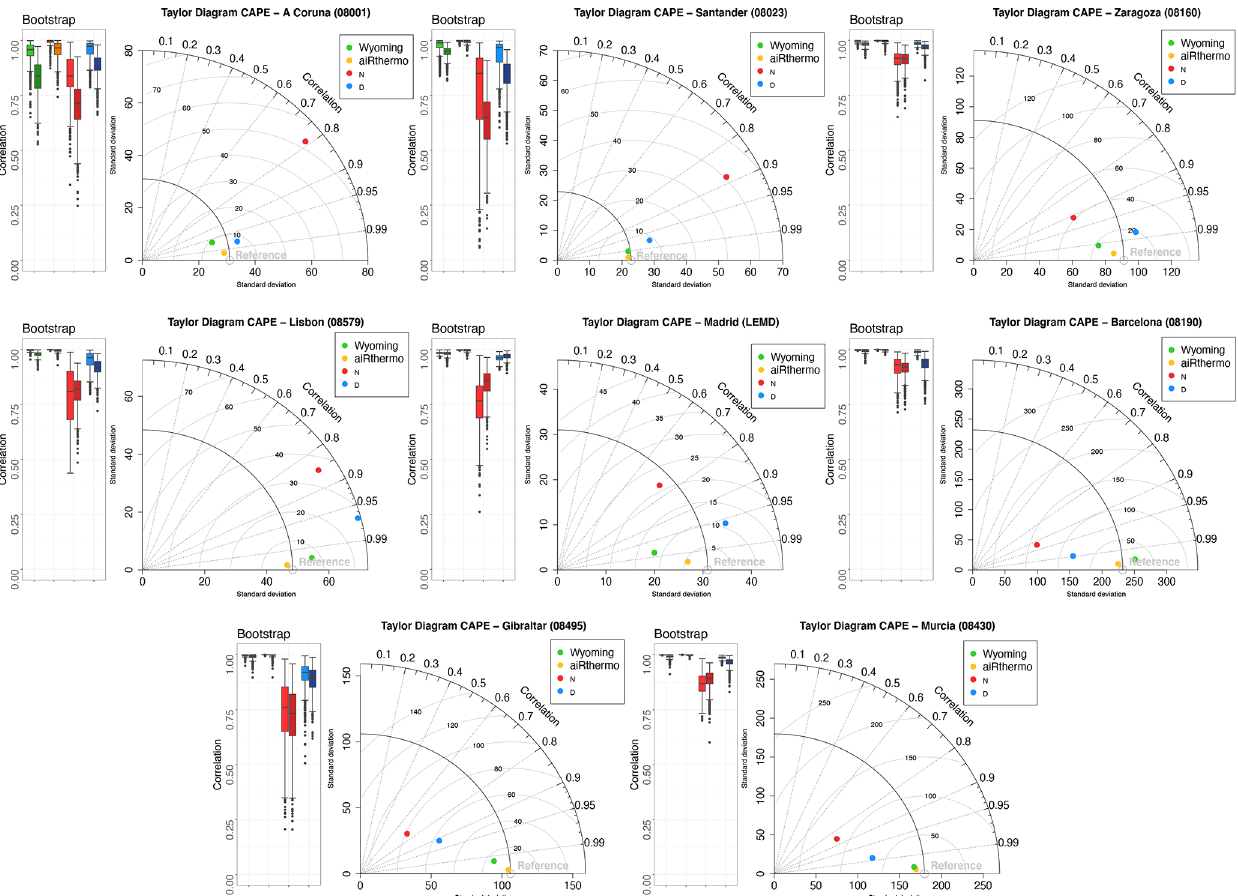
Figure 3. Same as Fig. 2 but for